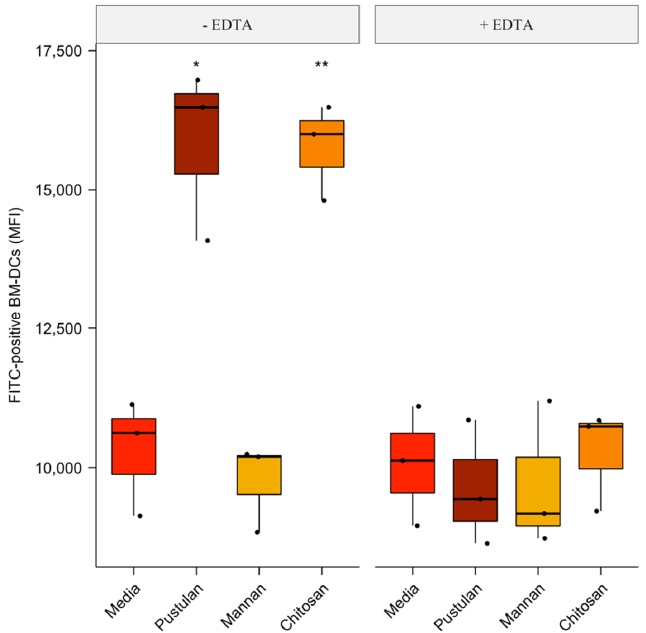
Figure 3. Cation-dependent effect of the glycan-based ligands on the endocytosis of FITC-labelled BSA by BM-DCs. Uptake of FITC-labelled BSA (10 µg/mL) in the presence of pustulan (100 µg/mL) or mannan (500 µg/mL) by BM-DCs preincubated for 15 min with or without EDTA (10 mM) was analysed by flow cytometry after 60 min Results are presented as boxplots showing the mean fluorescence intensity of the FITC-positive BM-DCs with individual values of biological replicates ( n = 3) plotted. A two-tailed Student’s t -test with Bonferroni multiple comparison correction was employed using the media as a reference group. A p value ≤ 0.05 was considered statistically significant and are indicated by asterisks. Significance level between the media and treatments is * p ≤ 0.05, ** p ≤ 0.01.